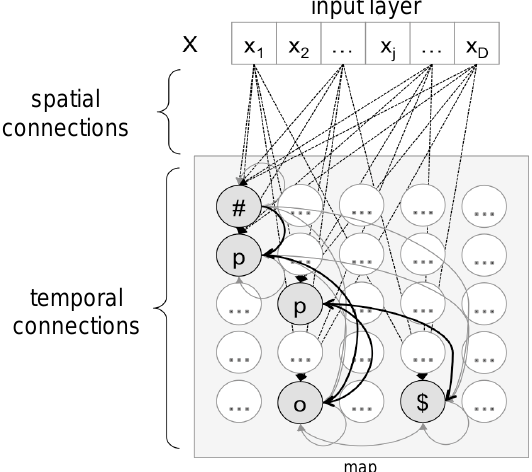
Figure 2. Functional architecture of a Temporal Self-Organizing Map (TSOM). As an example, map nodes show the activation pattern for the input string #pop$. Directed arcs stand for forward Hebbian connections between BMUs. “#” and “$” are respectively the start and the end of input